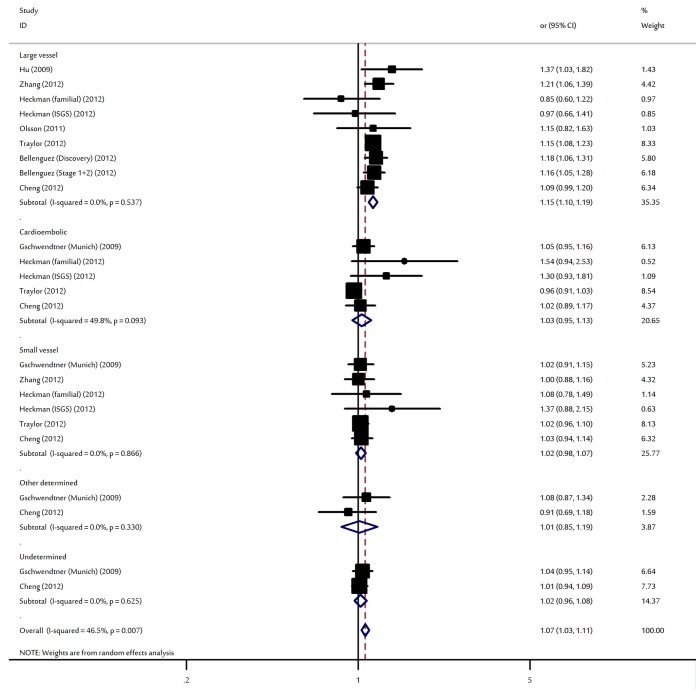
Forest plot for the association between rs10757278 and ischemic stroke risk by stroke subtype status.